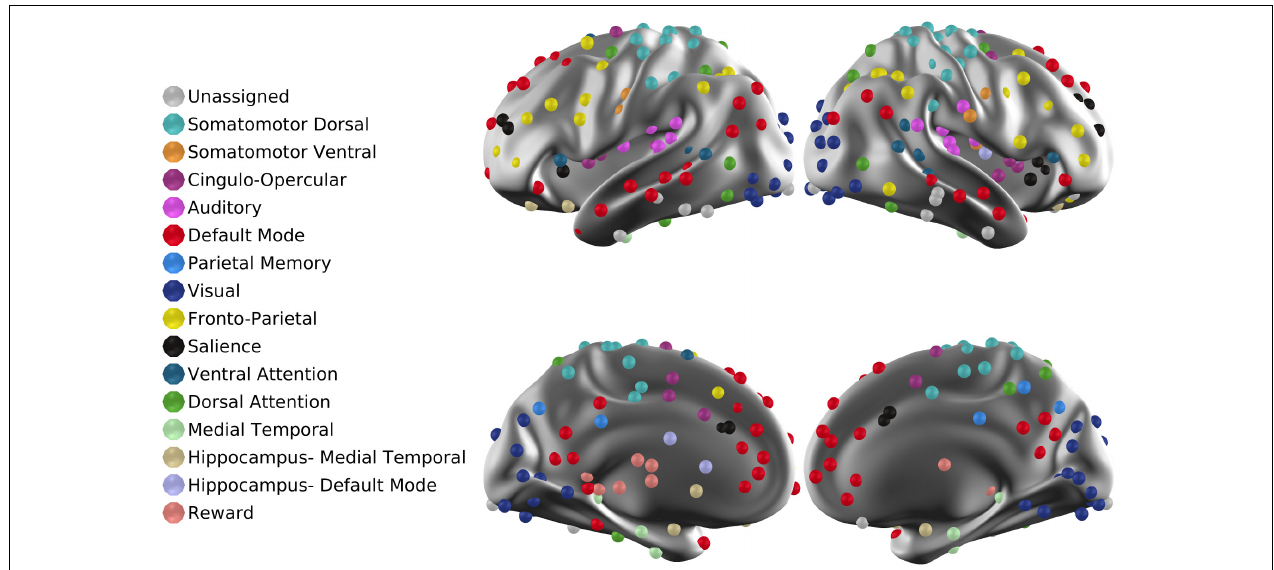
FIGURE 1 | ROIs projected onto the cortical surface. The total number of ROIs is 300. Each ROI is associated with one of 16 RSNs. “Unassigned” refers to regions of the brain in which fMRI signals are unreliable owing to susceptibility